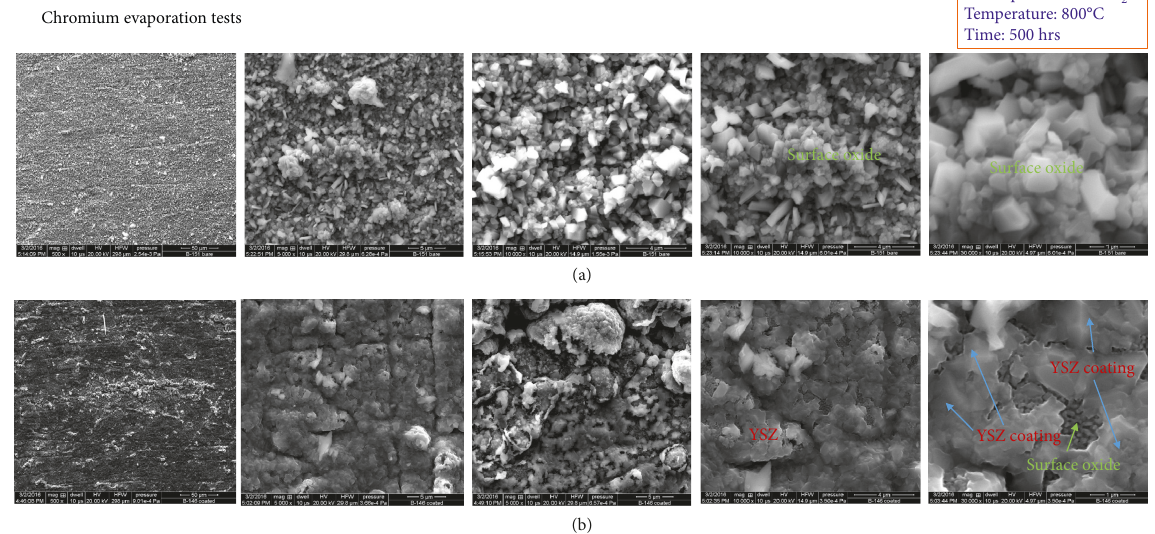
Figure 23: Cr evaporation test: SEM images of (a) uncoated and (b) YSZ-coated 430SS substrates (1-inch × 1-inch × 0.020-inch) shown at various magnifications following 500 h at 800 ° C in air/3% H2O